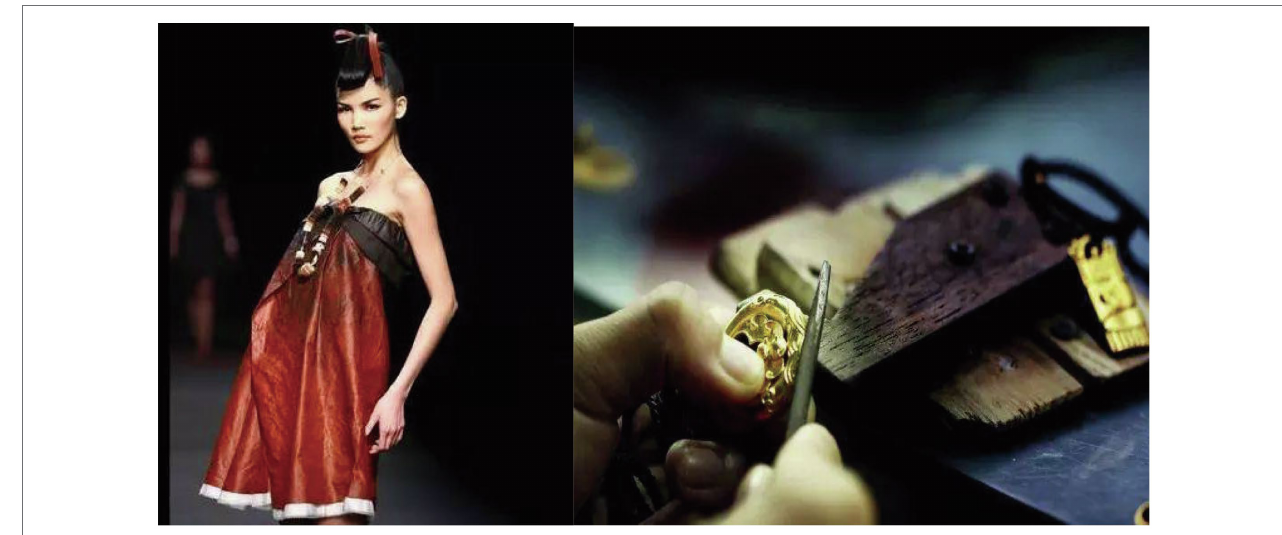
FIGURE 4 | Craftsmanship of Shang Xia’s bamboo weaving teaware and Xi Pi lacquer collected by British Museum. The photo displayed on the left was taken and kindly provided by Tangy Collection’s retail manager Mrs. Xu. The photo on the right was taken and kindly provided by Chou Tai Fook’s regional manager Mr.